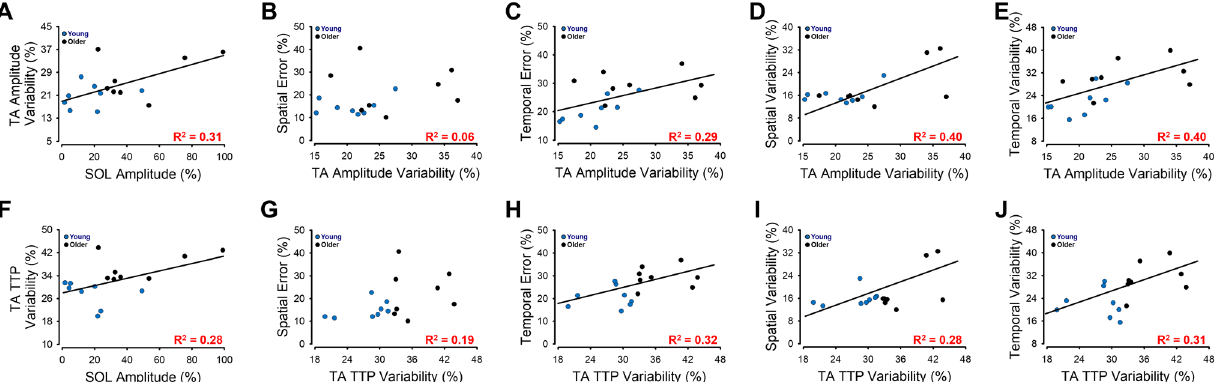
Figure 5. TA muscle activity associations with SOL muscle activity and endpoint control for young and older adults. SOL muscle activity significantly and positively associated with TA amplitude variability ( A ). Consequently, TA amplitude variability did not significantly associate with spatial error ( B ) but significantly and positively associated with temporal error ( C ), spatial variability ( D ), and temporal variability ( E ). Similarly, SOL muscle activity significantly and positively associated with TA time-to-peak (TTP) variability ( F ). Moreover, TA TTP variability did not significantly associate with spatial error ( G ) but significantly and positively associated with temporal error ( H ), spatial variability ( I ), and temporal variability ( J ).